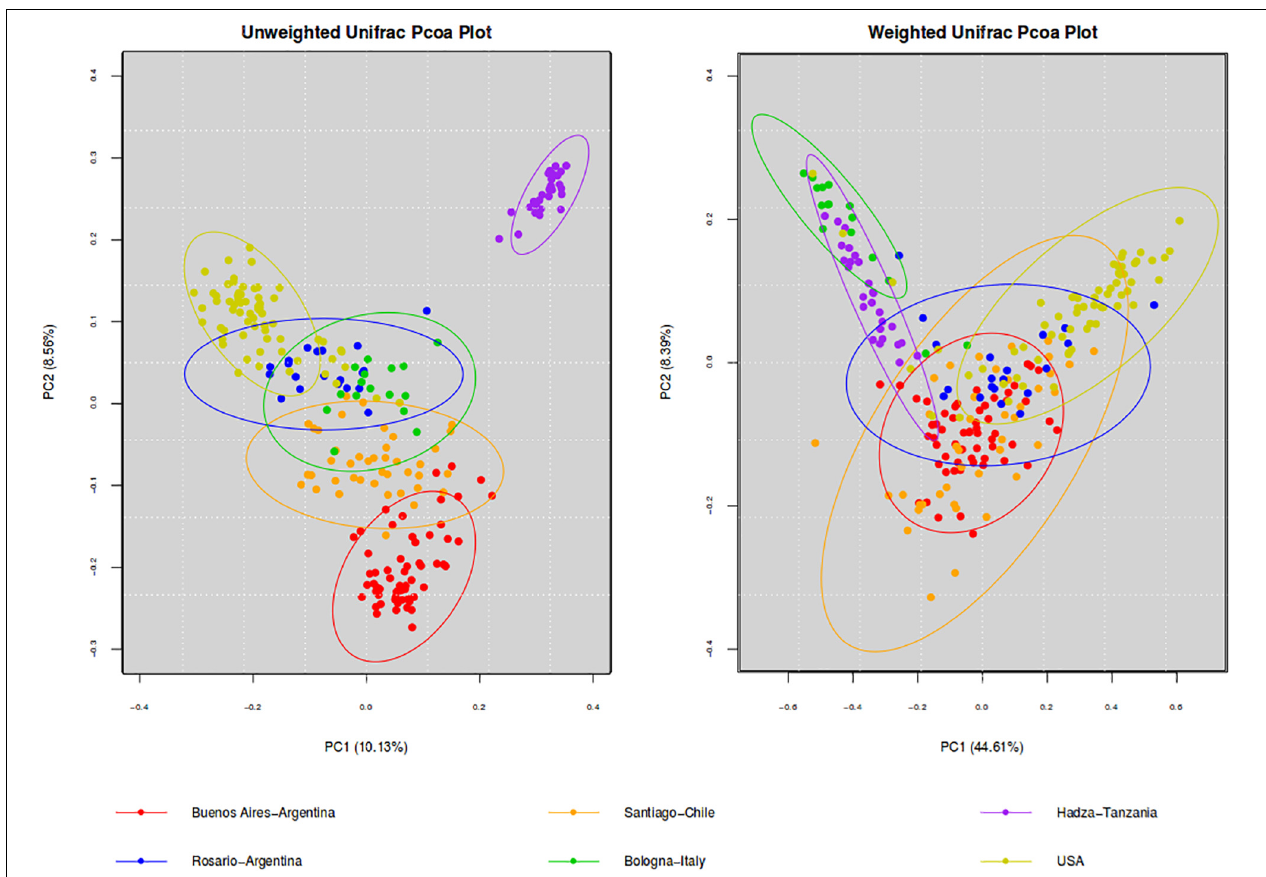
FIGURE 1 | PCoA of beta diversity values (unweighted and weighted Unifrac distances). Comparison of the gut microbiota from individuals of BA and other geographic locations. Ellipses were showed confidence interval of 95%.